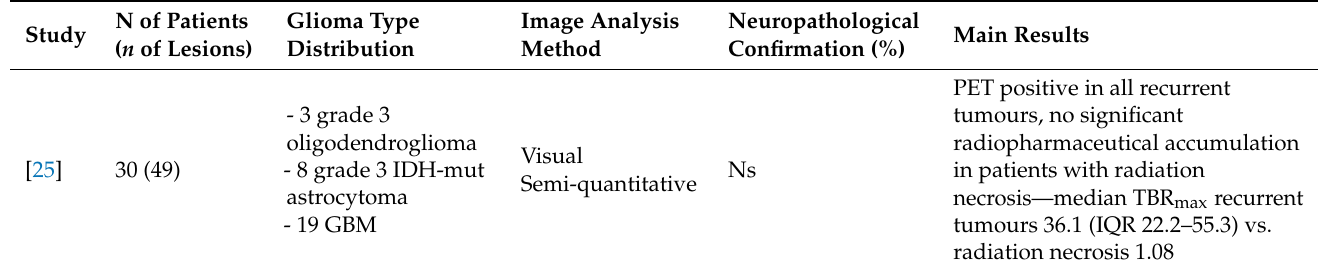
Table 5. Summary of studies investigating the diagnostic accuracy of [ 68 Ga]PSMA-11